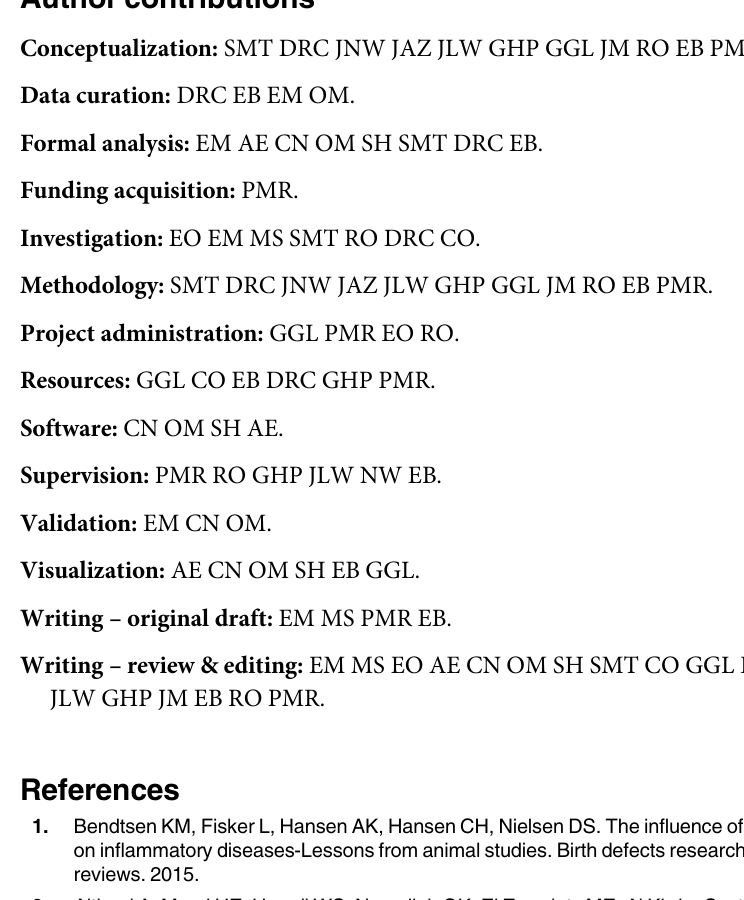
S2 Table. Master primer table with exact primer sequences. S3 Table. Excel file of sample-level microbiome data. S4 Table. Correlates of individual-level diversity (rarefied OTU count), multivariable lin- ear mixed regression (N = 107). S5 Table. Correlates of microbial similarity (Bray-Curtis distance metric) between chil- dren (N =